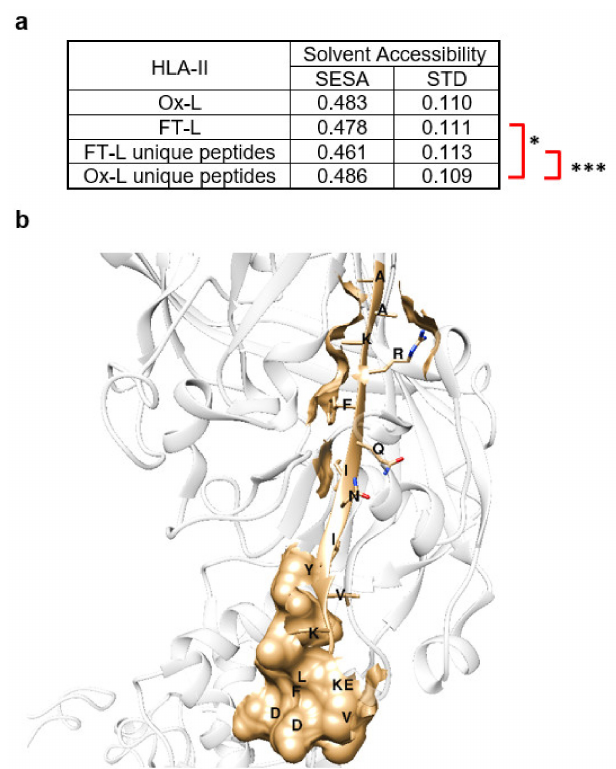
Figure 7. Analysis of solvent exposure for HLA-II ligand peptides indentified in this study in their source proteins. ( a ) Average solvent accessibility (SESA) for HLA-II ligand peptides isolated from mo-DCs loaded with the indicated conditions; unique peptides indicates peptides only identified in the indicated condition. SESA values were estimated by mapping each peptide on the 3D structure of the source protein and then calculating its surface exposure; statistical analysis: * p < 0.05; *** p < 0.001 ( b ) Surface exposure representation of the peptide AAKRFQINIYVKKLDDFVE, belonging to lysosome membrane protein 2 (residues 379.A–397.A) with a calculated SESA value of 0.430; protein structure retrieved from the Protein Data Bank: 4f7b, as an